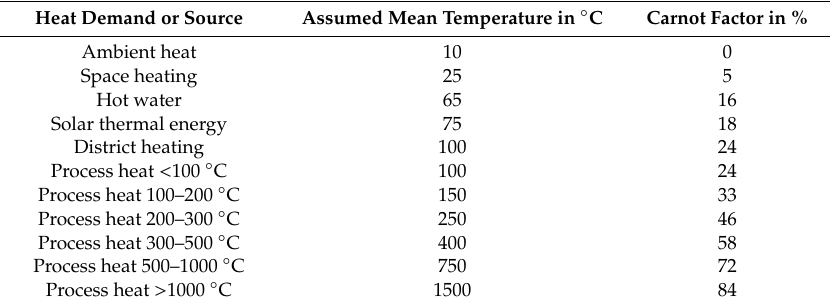
Table A3. Assumed mean temperatures and Carnot Factor for the di ff erent heat applications and sources (surrounding temperature 10 ◦ C).